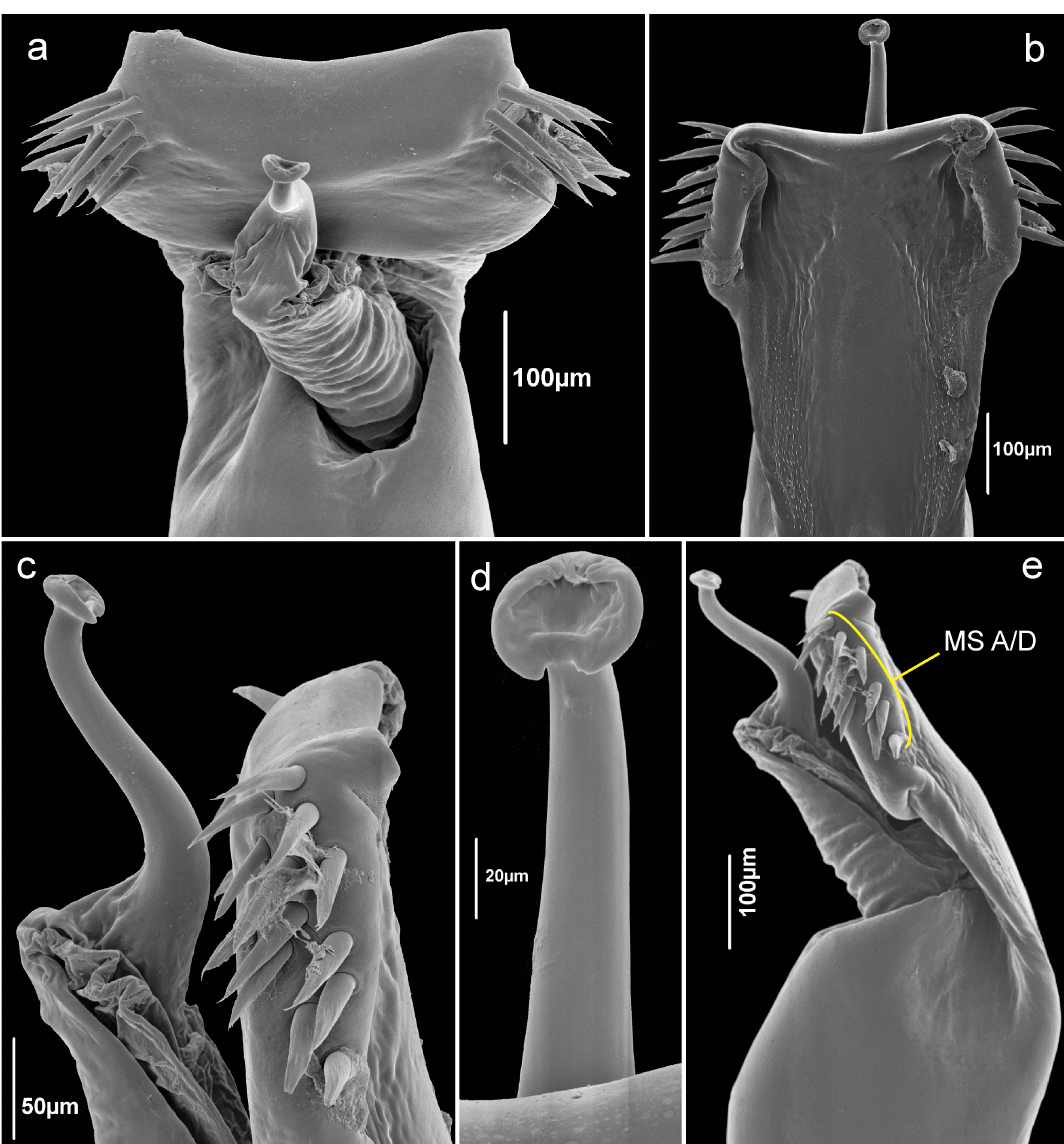
Fig. 15. Phalangodus kuryi sp. nov., holotype, ♂ (ICN-AO-1436). Penis, distal portion. a . Dorsodistal view. b . Ventral view. c . Detail of MS, lateral view. d . Stylar caps, ventral view. e . Lateral view. Abbreviations: MS